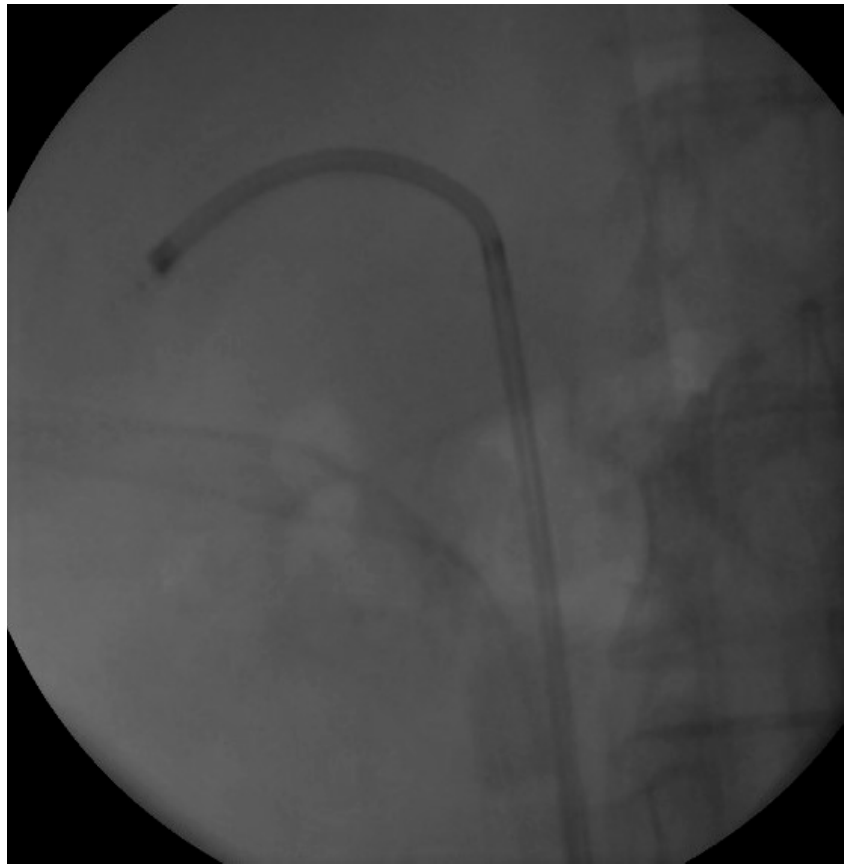
Figure 5. Image at the end of the operation showing no more contrast agent.